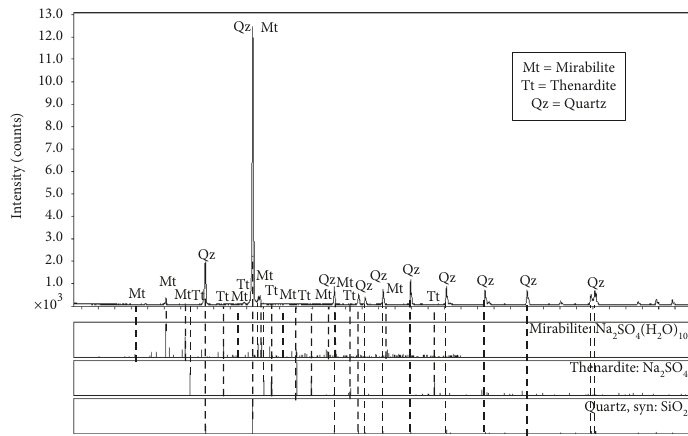
Figure 4: XRD results.